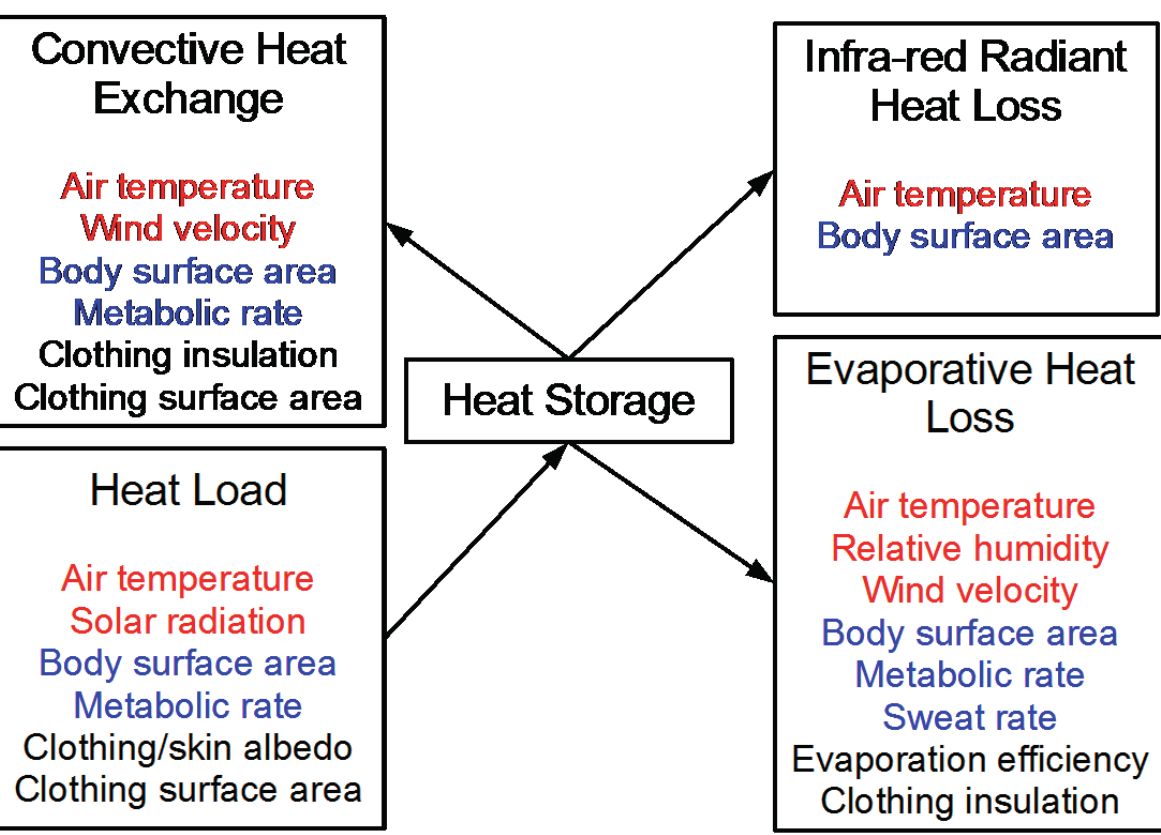
Figure 1. The MANMO model showing heat flow (loss or gain), with weather inputs in red, individual characteristics in blue, and fixed values in black. Weather conditions are sourced from the Australian Bureau of Meteorology. Body surface area is a function of height and weight, which in turn is driven by age and sex. Metabolic rate varies according to age and sex characteristics, as outlined in the Supplementary Material (Figure S1 and Table S1). Sweat rates are assumed to vary by sex and age as described in the text. Fixed values are listed in Table